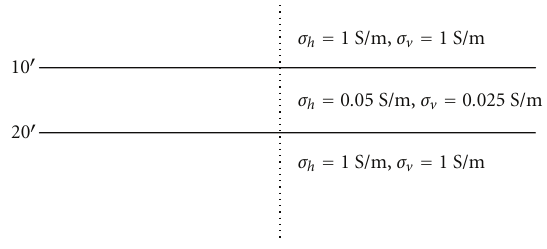
Figure 7: A three-layer anisotropic formation.